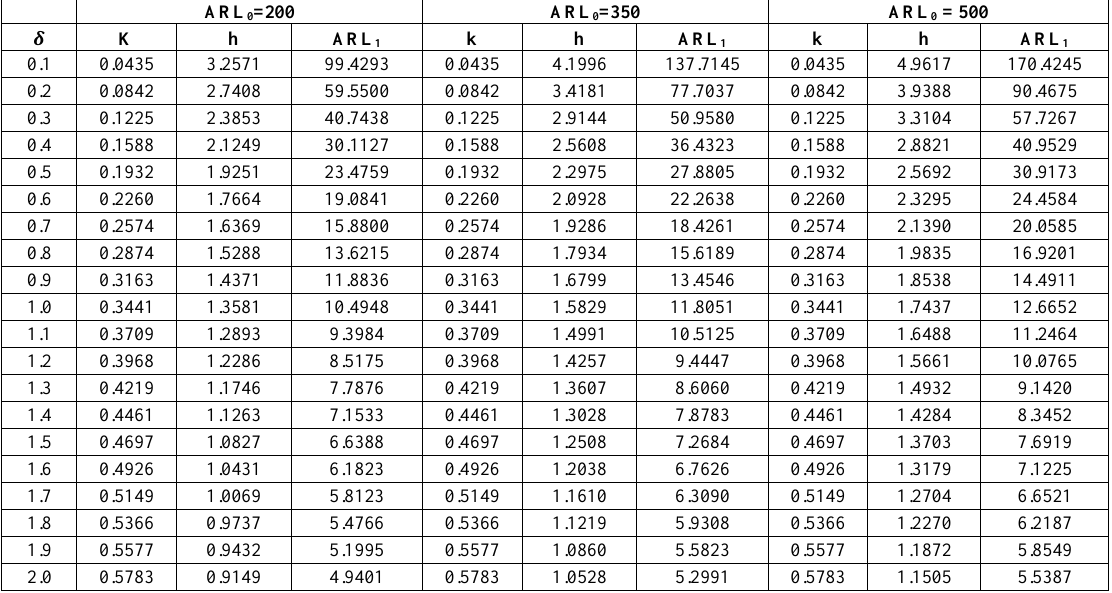
Table 4. Combined Shewhart-CUSUM scheme parameters and out of control ARL to detect 𝛿 standard deviation shift. ARL 0 =200 ARL 0 =350 ARL 0 =